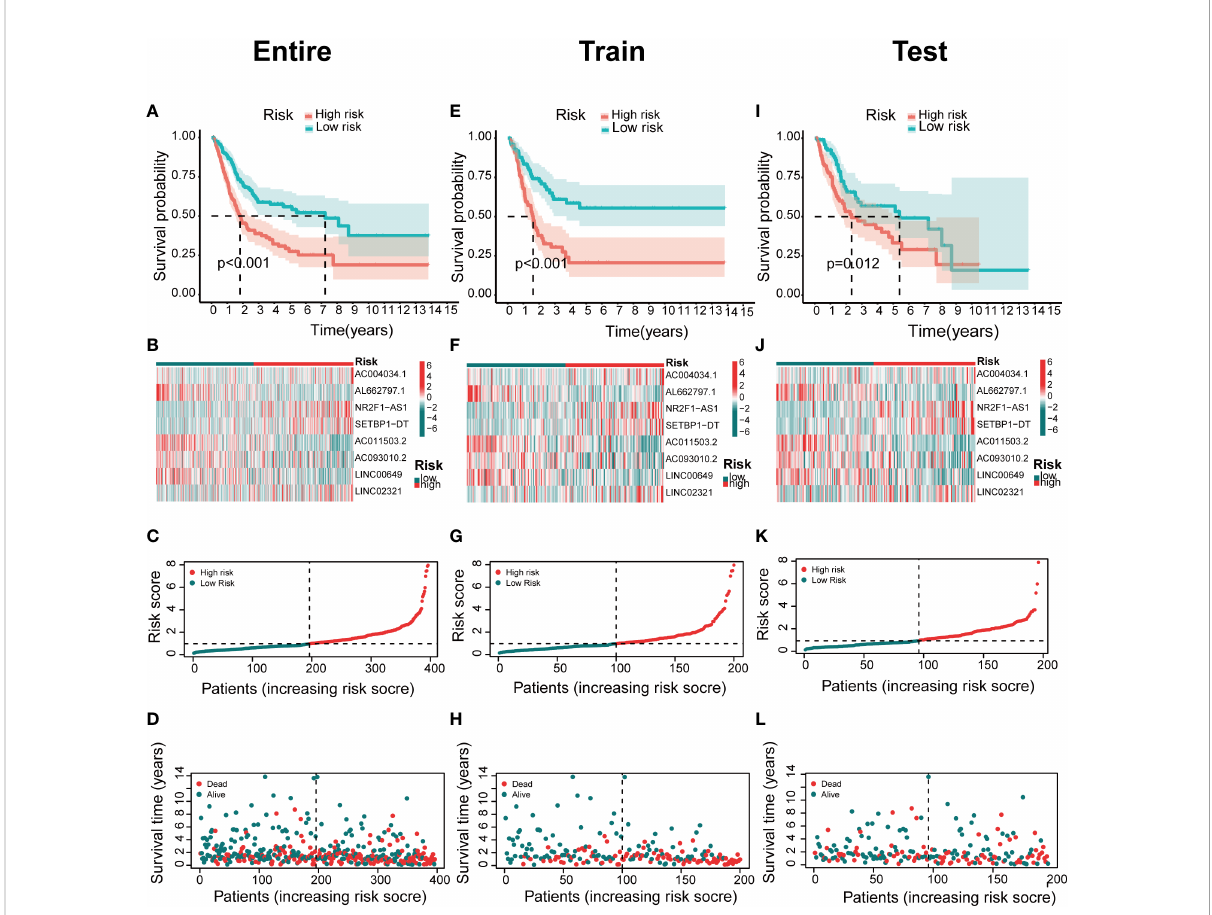
FIGURE 4 Association between basement membrane-associated lncRNA signatures and prognosis in a risk model. The Kaplan – Meier curves of overall survival, heatmap, risk score, survival time for BCa patients in the (A – D) entire set. (E – H) train set. (I – L) test